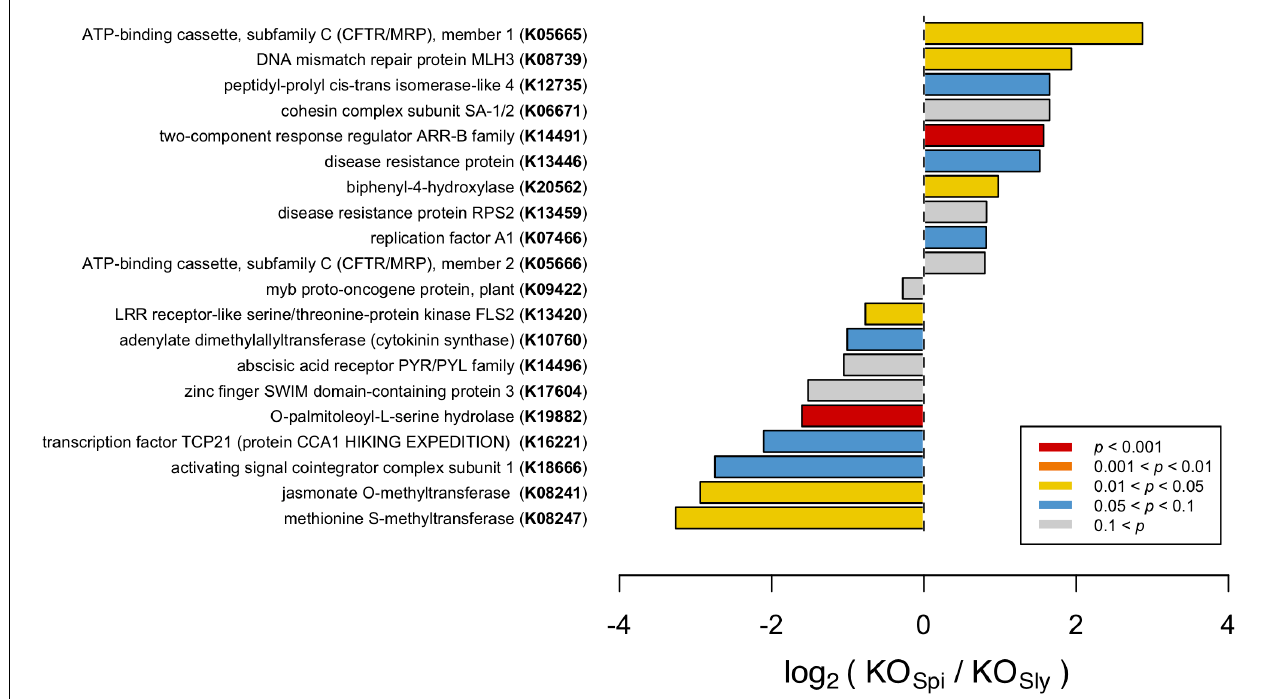
FIGURE 4 | Comparison of KO term frequency in S. pimpinellifolium (KO Spi ) and S. lycopersicum (KO Sly ) genomes, presented as the ratio on a log 2 scale. Bars are color-coded based on the P -values from a Fisher’s exact test-based enrichment analysis (corrected for multiplicity using the Bonferroni method); the top 20 entries with the highest P values are presented. Entries are ordered based on log 2